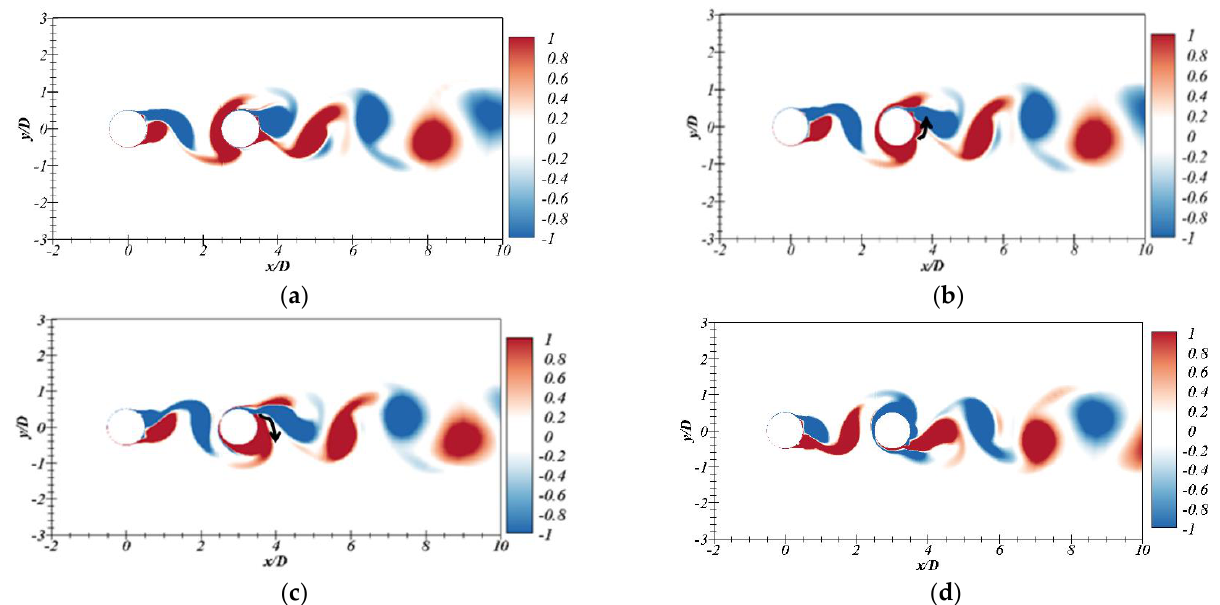
Figure 11. Instantaneous contours of the spanwise vorticity for 𝐿/𝐷 = 3 at: ( a ) 𝑡𝐷/𝑈 ∞ = 285.5 ; ( b ) 𝑡𝐷/𝑈 ∞ = 286 ; ( c ) 𝑡𝐷/𝑈 ∞ = 287 ; ( d ) 𝑡𝐷/𝑈 ∞ = 288 .